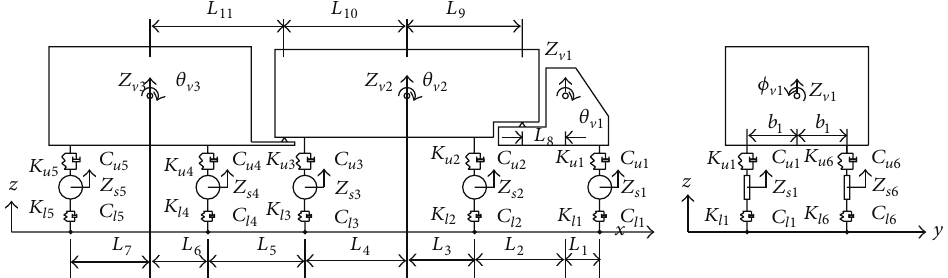
Figure 5: Dynamic model of a tractor-trailer [79].